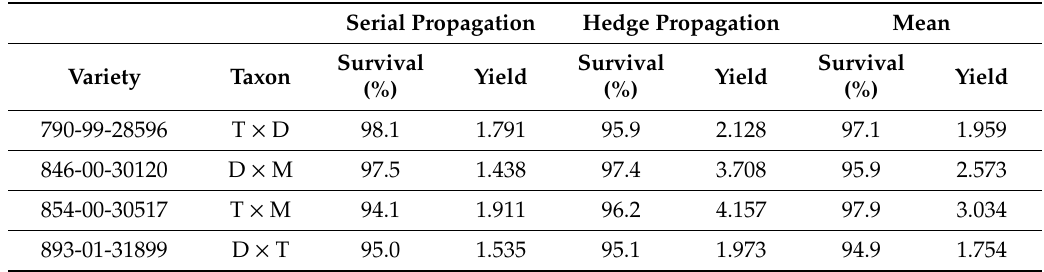
Table 6. Macro-cutting survival and yield (cuttings plant − 1 ) during greenhouse propagation 1